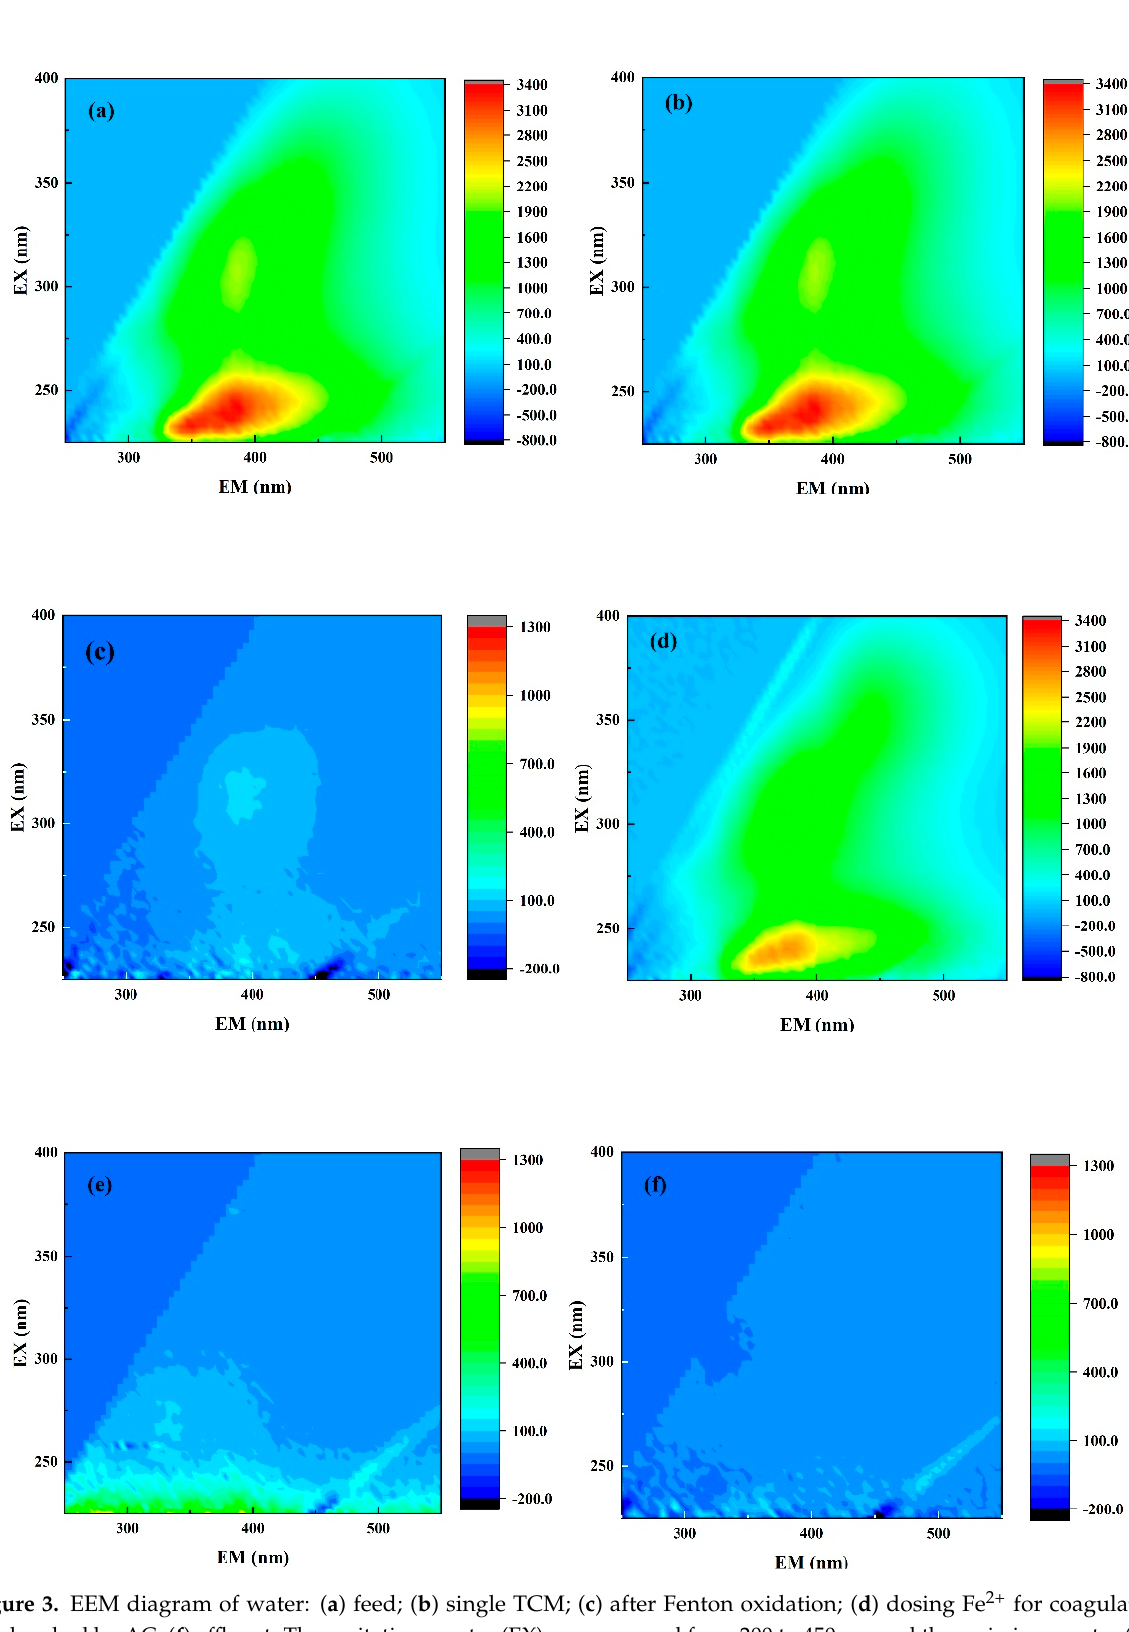
Figure 3. EEM diagram of water: ( a ) feed; ( b ) single TCM; ( c ) after Fenton oxidation; ( d ) dosing Fe 2+ for coagulation; ( e ) absorbed by AC; ( f ) effluent. The excitation spectra (EX) were scanned from 200 to 450 nm and the emission spectra (EM) were scanned from 240 to 600 nm. The scanning velocity was 50